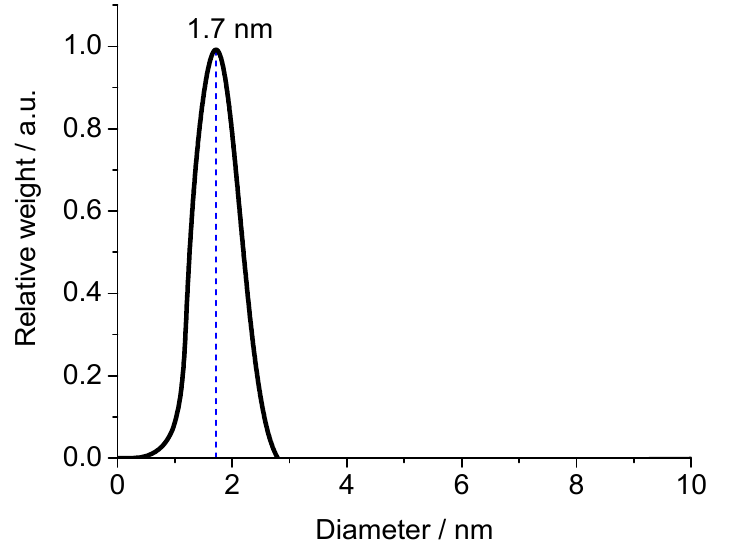
Figure 2. Disc centrifugal sedimentation data (DCS) of Au-GSH nanoparticles.